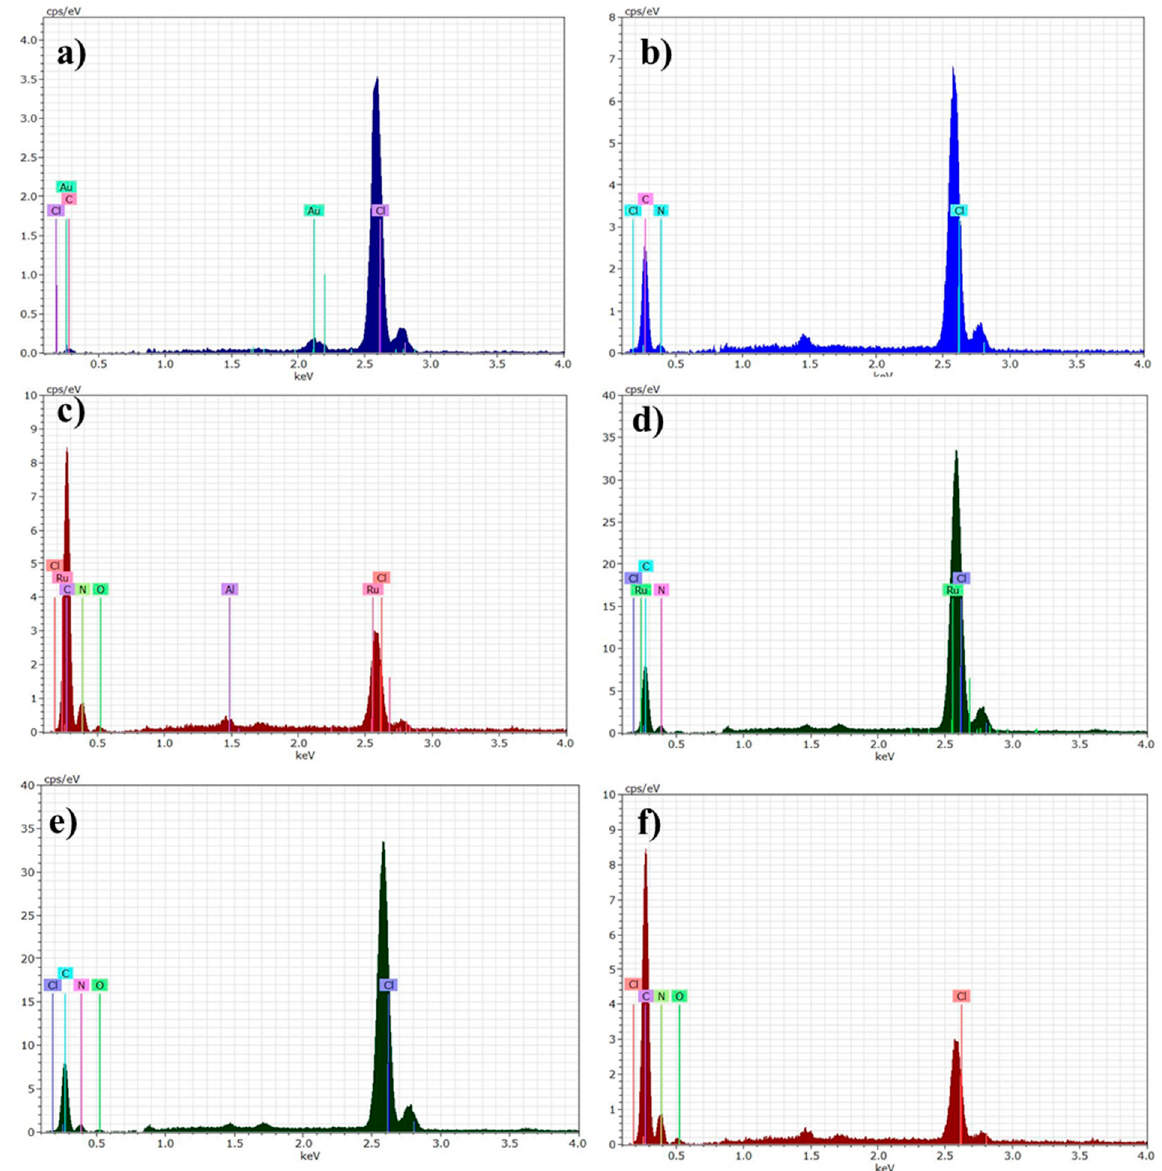
Figure 3. EDX spectra of ( a ) blank PVC, ( b ) PVC-ed, ( c ) PVC-ed/o-OMe, ( d ) PVC-ed/p-OH, ( e ) PVC-ed/p-OMe, ( f ) PVC-ed/o-NO 2.